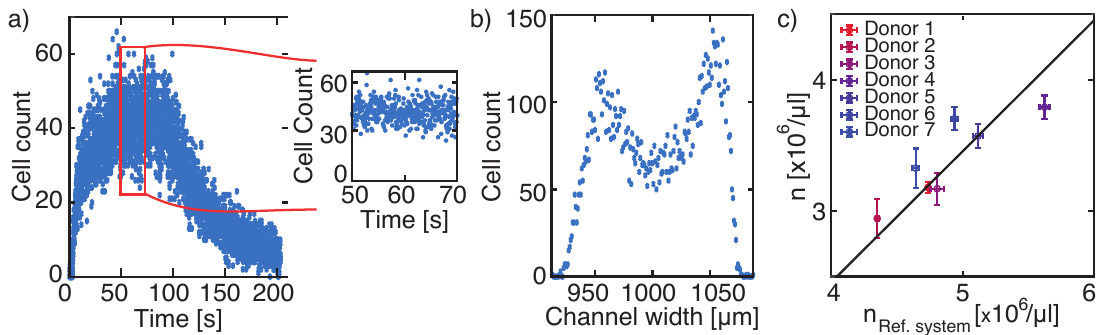
Figure 3. Hydrodynamic focusing approach. ( a ) Cell counting per frame over 210s, where during a selected time period of 20s the cell count is constant (red square). ( b ) Cell distribution along the centre part of the channel width. As all cells are recorded in the centre FOV during the dedicated 20s, solely a volume determination is necessary for determining the corresponding cell concentration. ( c ) Comparison of cell concentrations obtained from different donors measured with the reference system Siemens ADVIA 2120i to cell concentrations resulting from applying the hydrodynamic focusing approach. A linear correlation is found for the measured seven healthy donors with variations to the solid line of 2.22 ± 1.74%. However, the y-intercept for the straight line was located at − 1.62 × 10 6 / µ